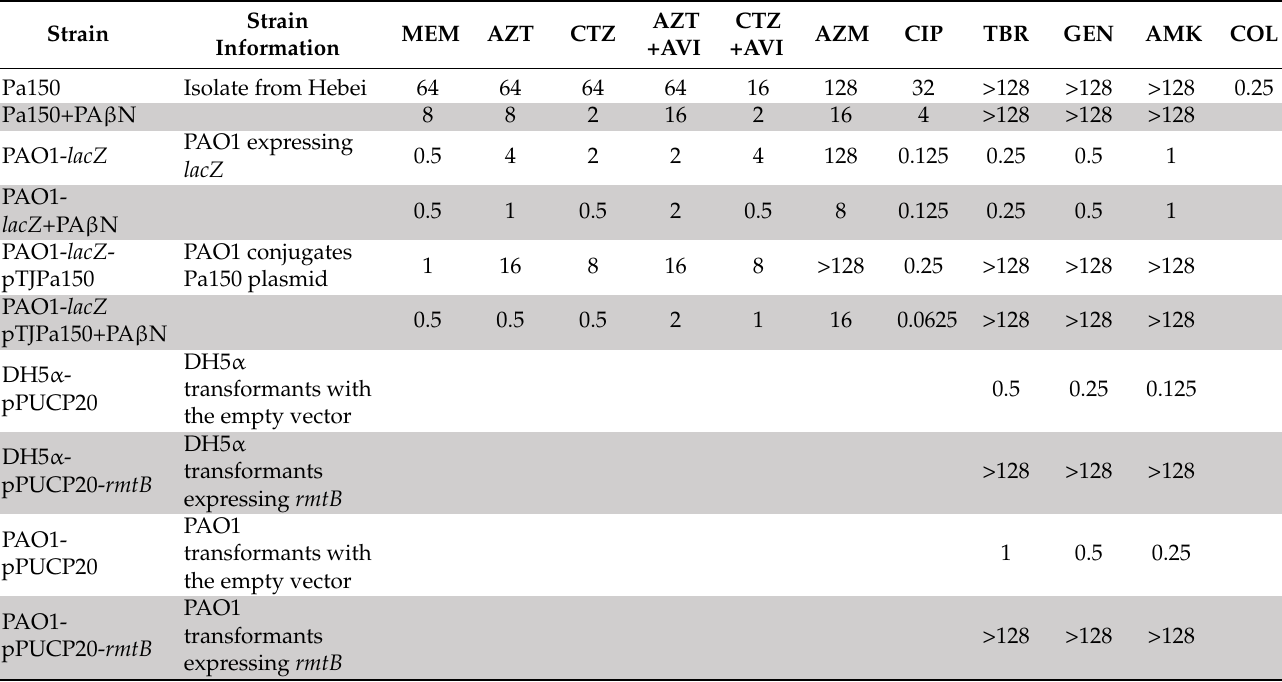
Table 1. MICs ( µ g/mL) for indicated